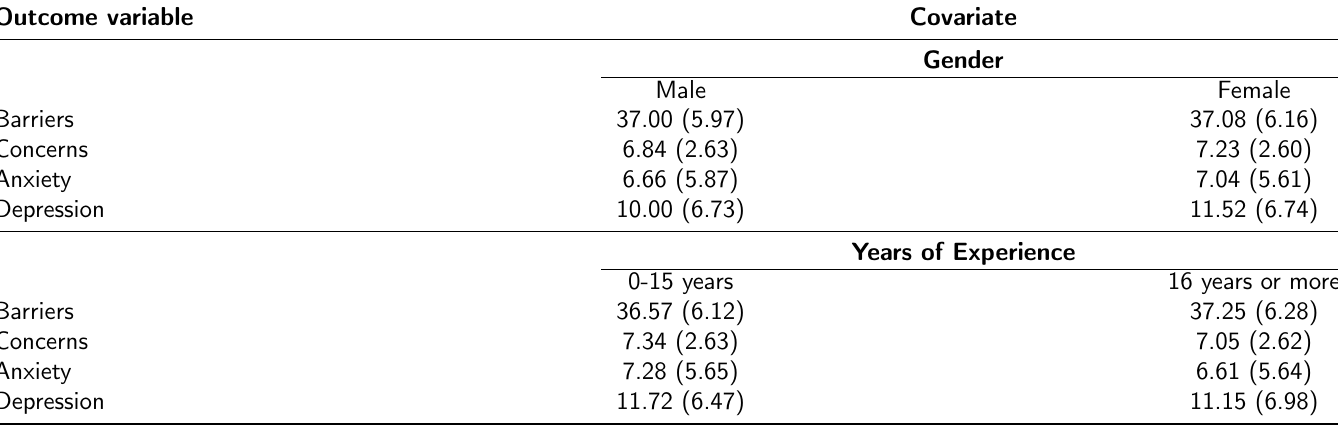
Appendix Table 1: Educator-reported barriers, concerns, and symptoms of anxiety and depression by gender and years of